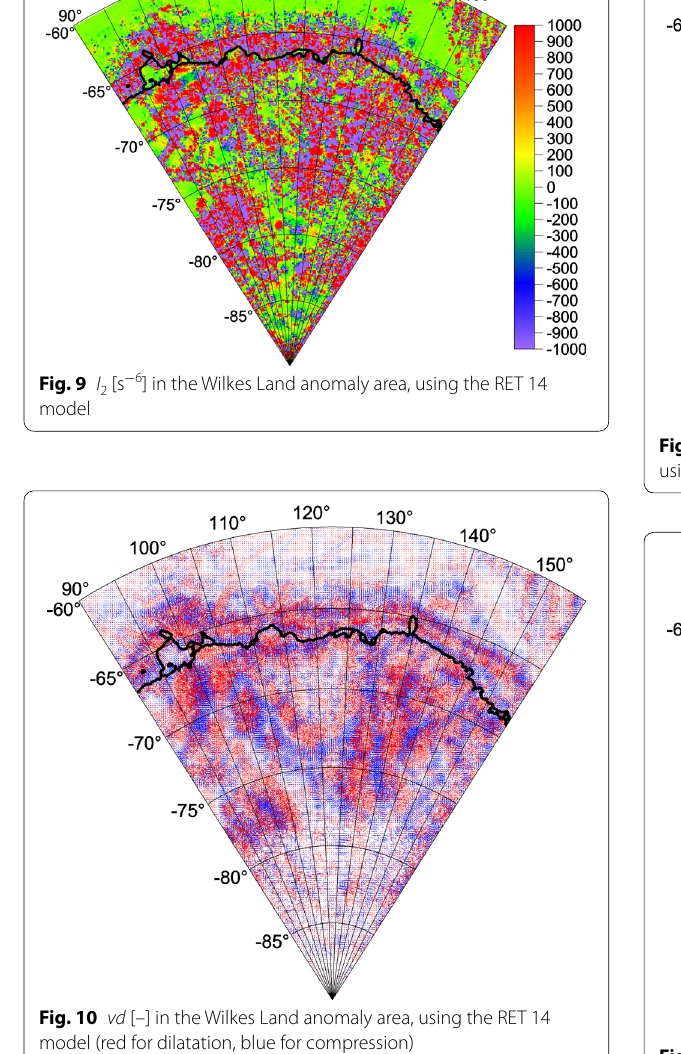
Fig. 12 T zz (Eötvös) in the Wilkes Land anomaly basin, computed using the RET 14 model. A possible river valley, now a subglacial river or relict of a river, has been